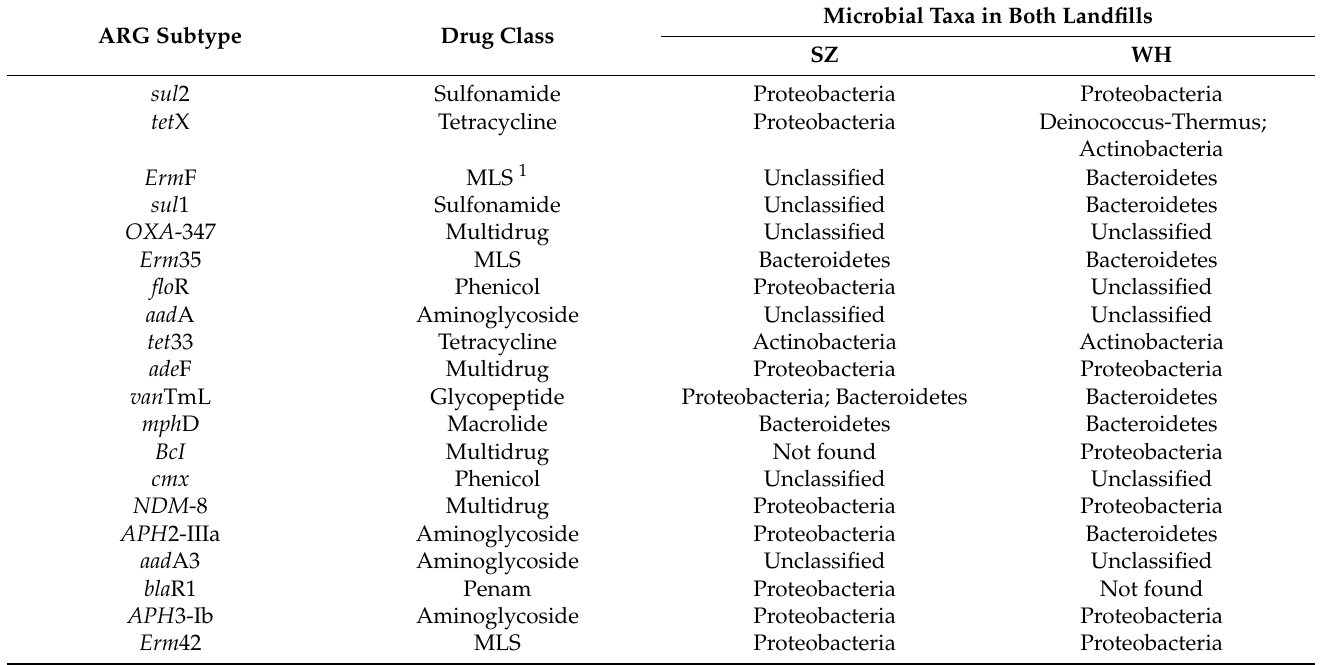
Table 2. The co-occurrence between top 20 ARG subtypes and microbial taxa in both landfills. ARG